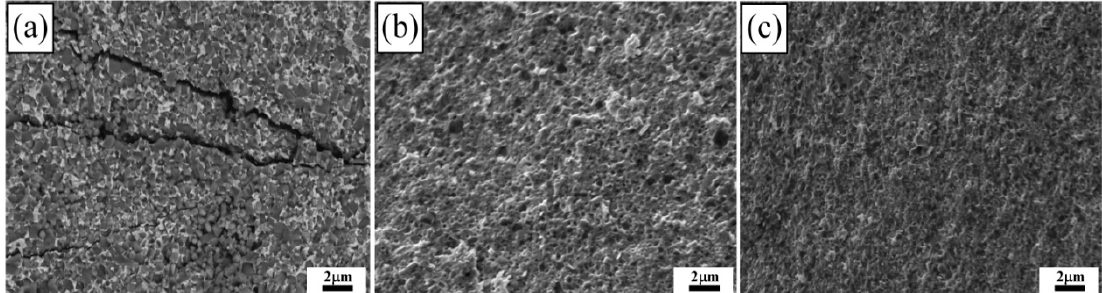
Figure 1 2 SEM images of the compression fractured surfaces for (TiC x N y –TiB 2 )/Ni cermets. ( a ) Figure 12. SEM images of the compression fractured surfaces for (TiC x N y –TiB